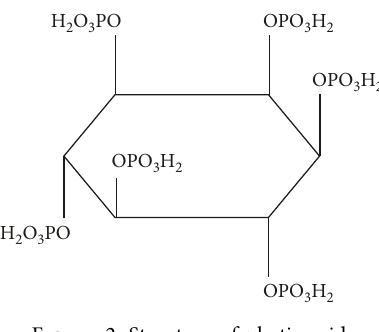
Figure 2: Structure of phytic